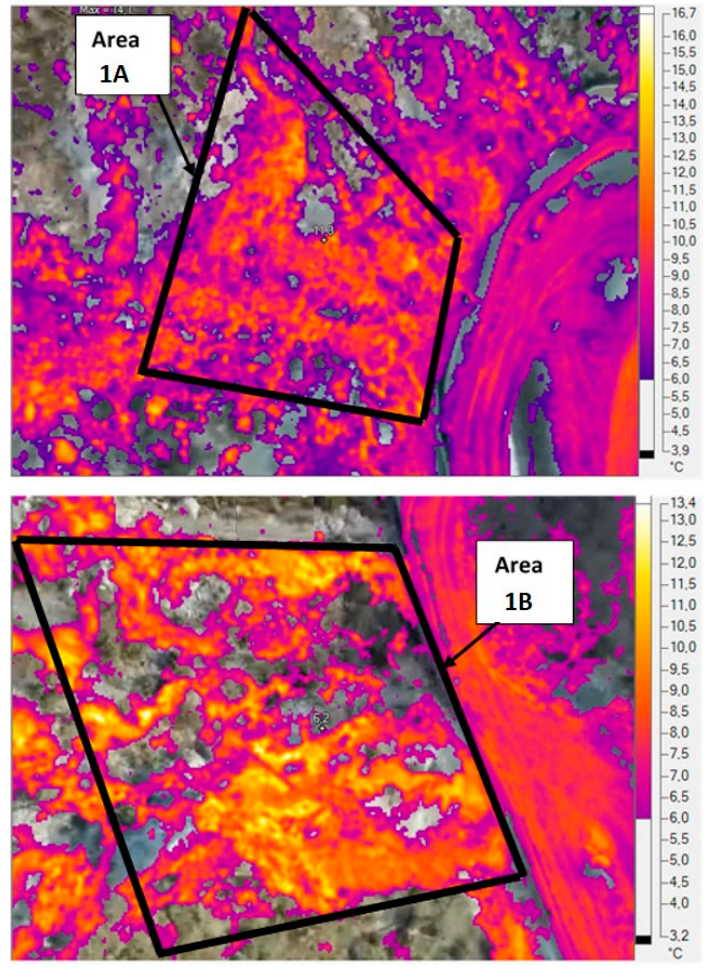
Figure 5. Thermographic data gathered for site No. 1 over areas 1A and 1B, Mount Scarpino. Table 1. Estimated methane flow rates and main parameters included in the calculation procedure.